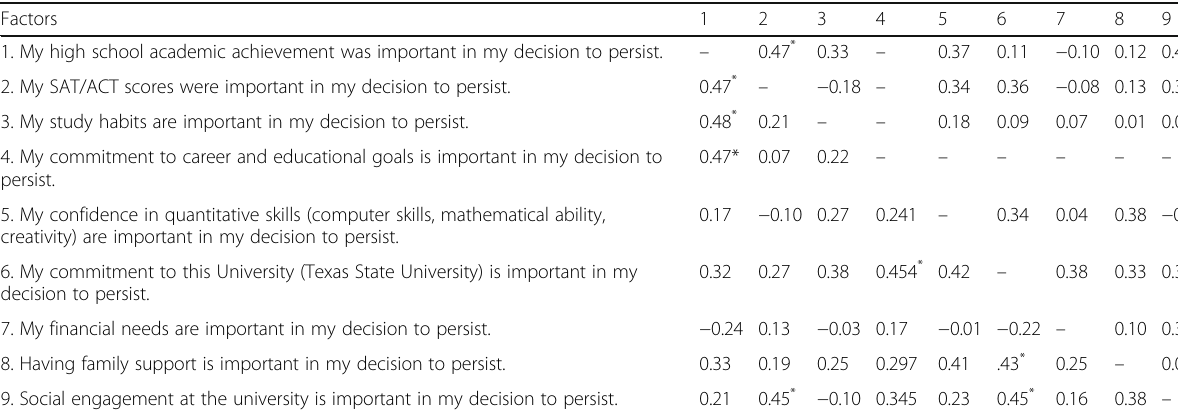
Table 12 Correlations for motivations to persist